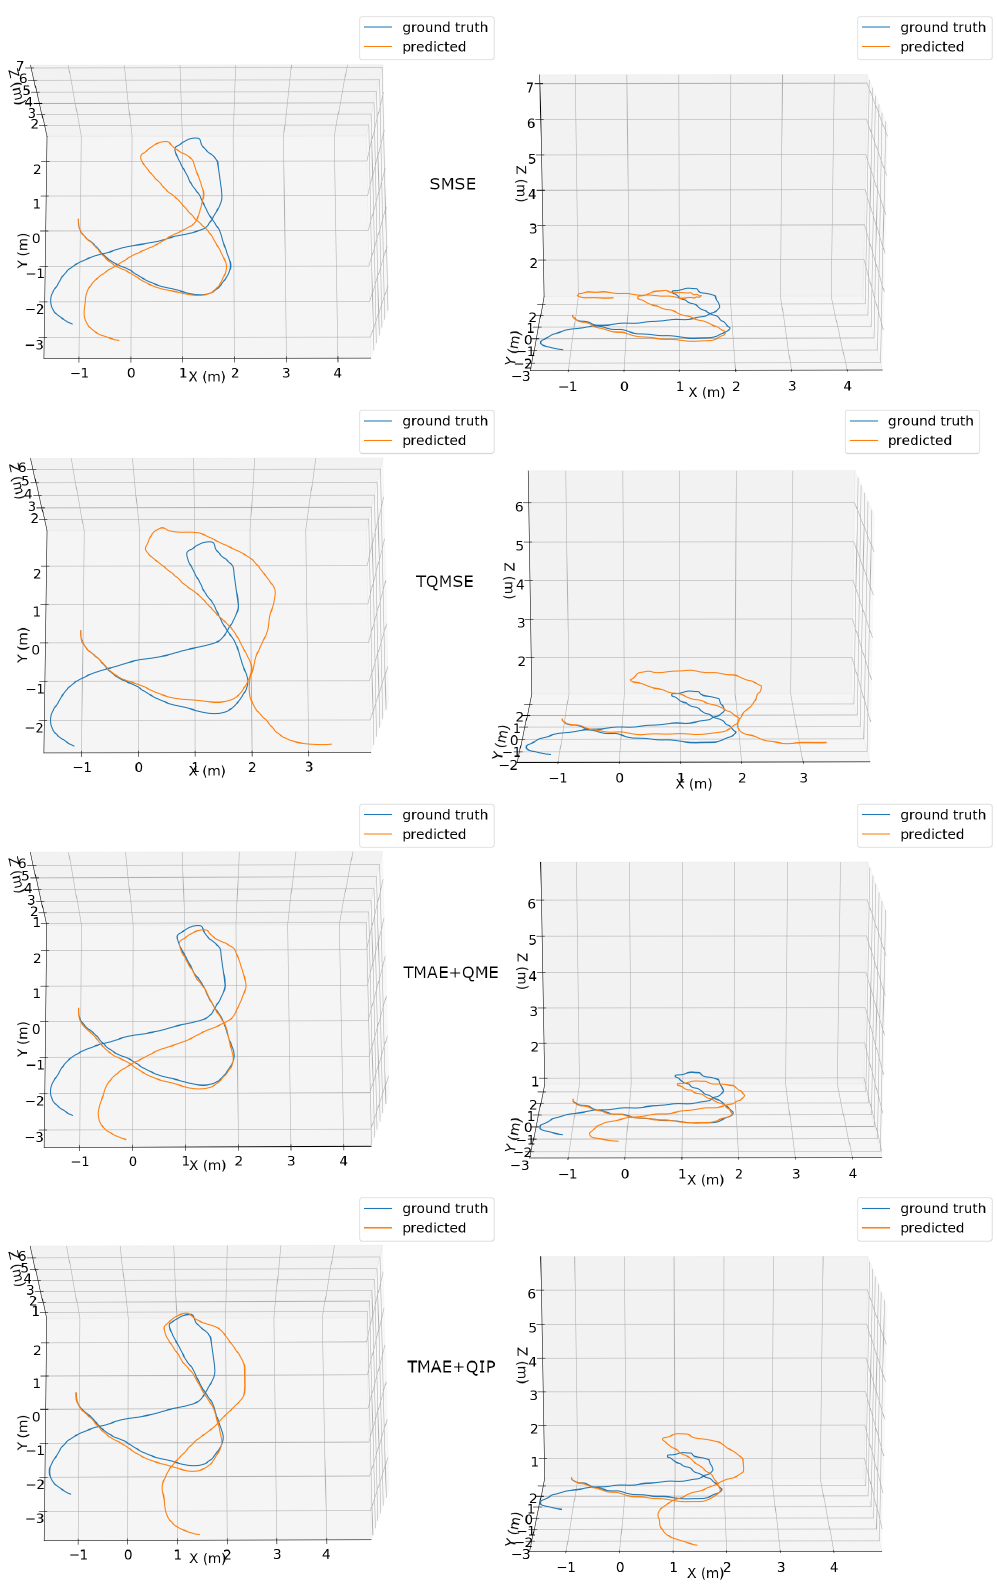
Figure 6. Top ( left column ) and side ( right column ) views of ground truth (blue) and predicted (orange) trajectories for an excerpt of the “handheld/data4/seq3” dataset using different configurations: SMSE ( first row ), TQMSE ( second row ), TMAE+QME ( third row ) and TMAE+QIP ( fourth row